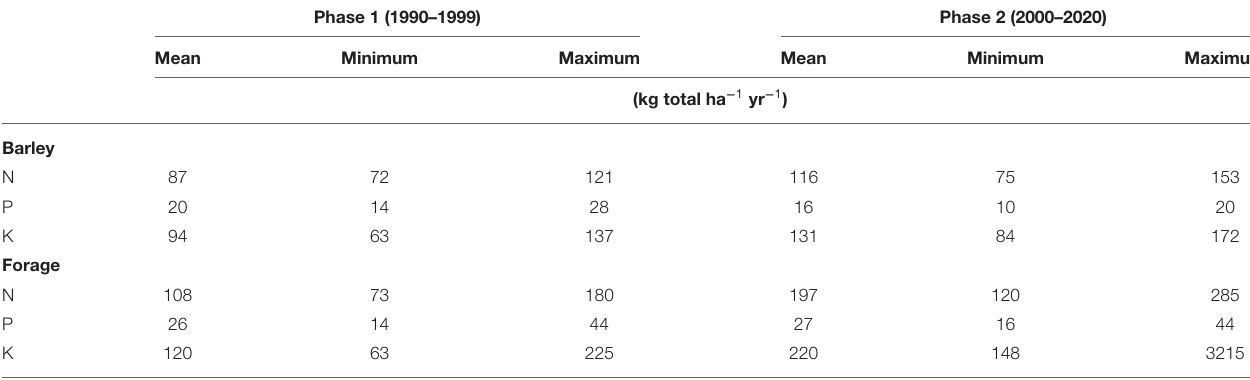
TABLE 1 | Mean, minimum, and maximum amount of nutrients applied from liquid dairy manure at Normandin site.